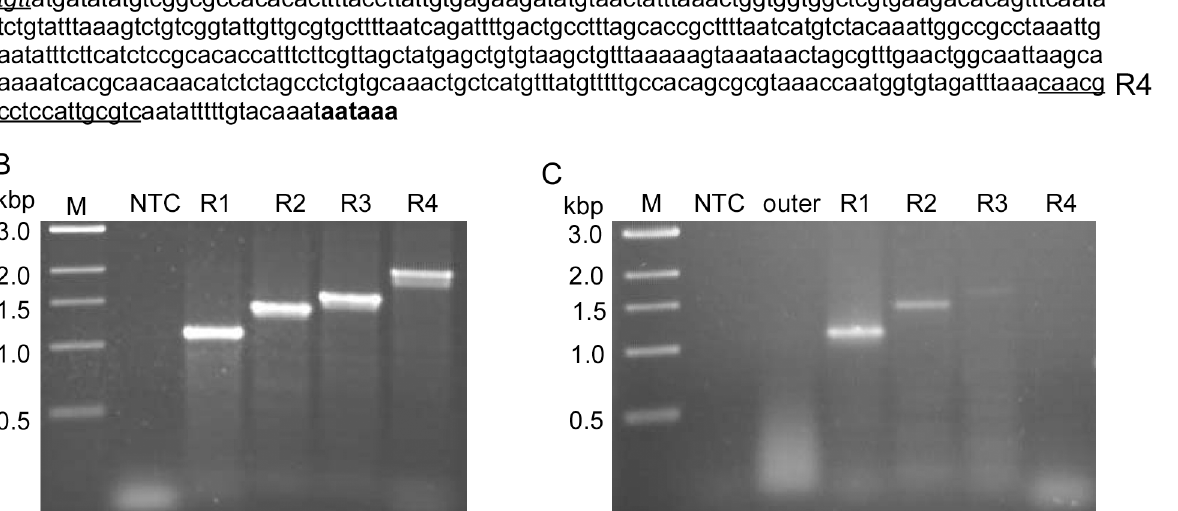
Fig 6. Polyadenylation signal analysis of the gp37 UTR of AcMNPV. A . Comparison of the 3 ’ UTRs of polh , egt , gp37 and SV40. UTR sequences were retrieved from GenBank and searched for the polyadenylation AATAAA and GU-rich motifs. UTR sequences start right after the gene translation stop codon, except SV40 polyA that starts with the 5 ’ end of the insert. The putative polyadenylation signal AAUAAA or AATAAA is in bold letters. Putative GU-rich motifs are in underlined italic letters. The primary 3 ’ end nucleotides are in capital letters. Underlines sequences are reverse primers for PCR. B . PCR analysis using GFP486F/gp37 reverse primers (R1, R2, R3 and R4) and plasmid DNA template (pAcgp37SV40 - , Fig 1). NTC, no-template control. M, DNA size marker. C . PCR same as B except that cDNA from mRNA isolated from the Sf21 cells infected with Acgp37SV40 - (Fig 1). Outer, 3 ’ RACE outer reverse primer